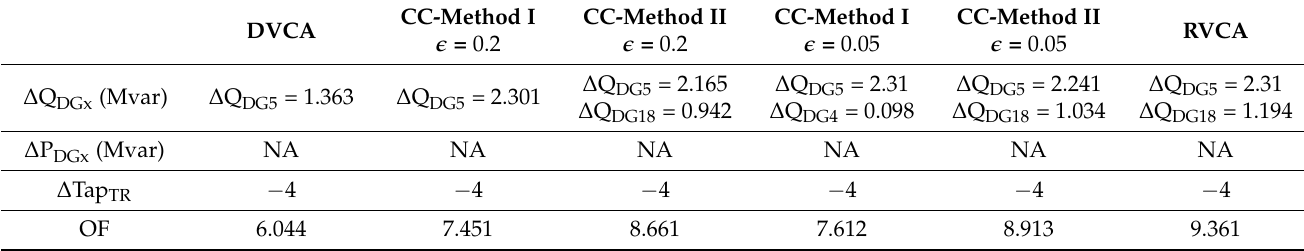
Table 2. Control decisions taken by the proposed CC framework and the